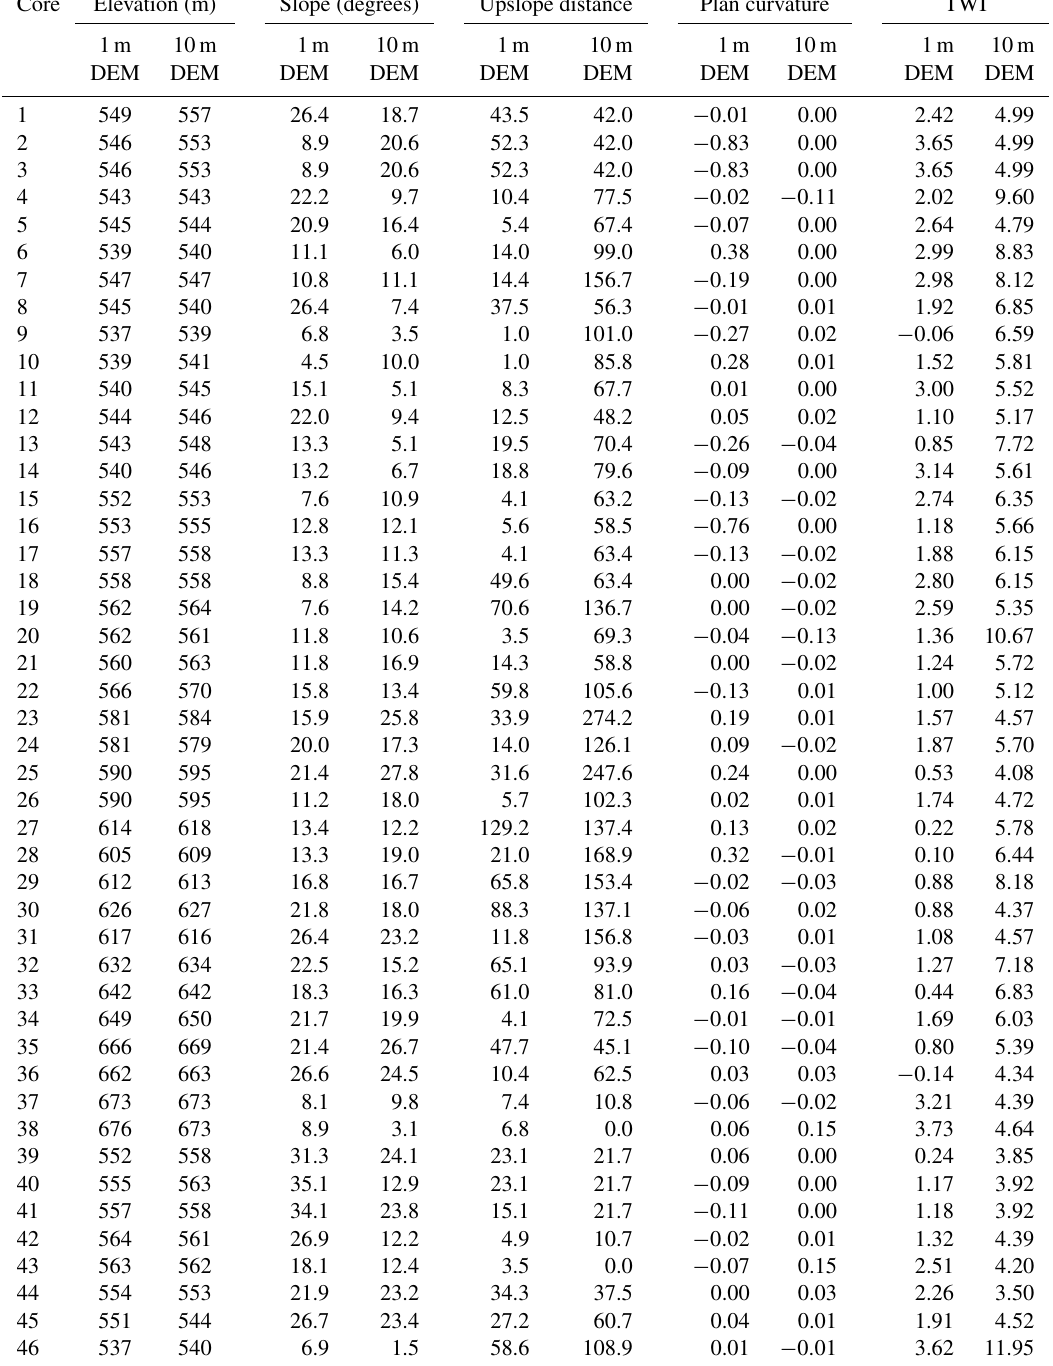
Table B1. Summary of topographic indices for all core sample locations (58 core samples, 46